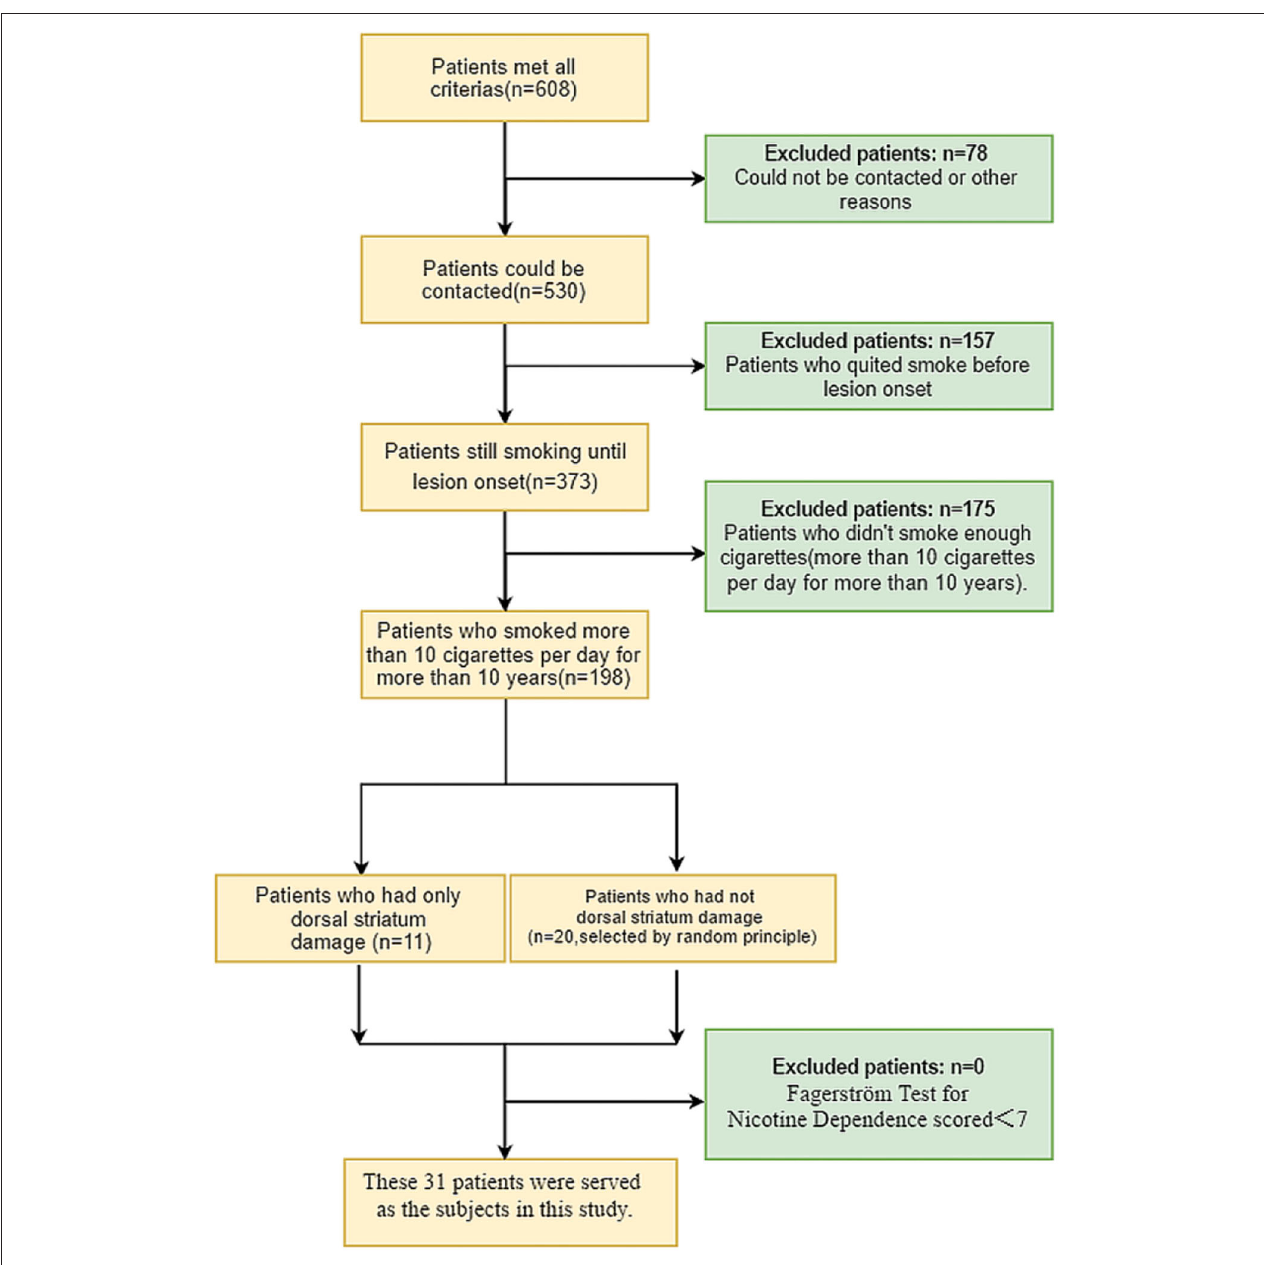
FIGURE 1 | Flow chart of patient inclusion.